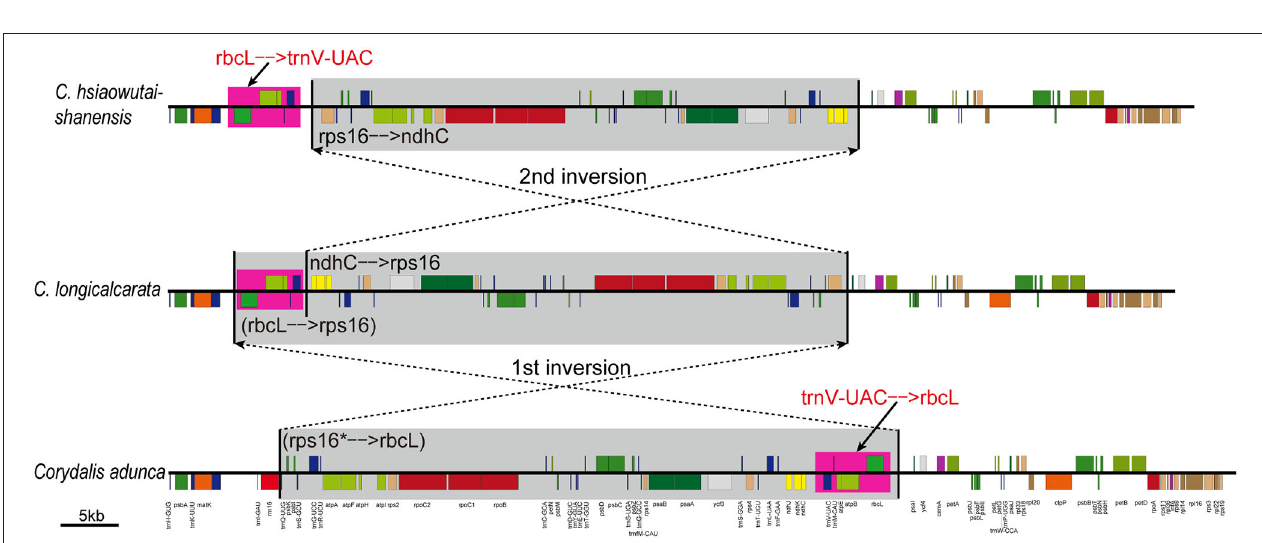
FIGURE 3 | The two inversions detected in Corydalis plastomes LSC region that could explain the translocation of the segment involving trnV-UAC – rbcL in clade IV + V + VI. The inverted regions were highlighted with gray background, while the translocated regions were highlighted with pink background.